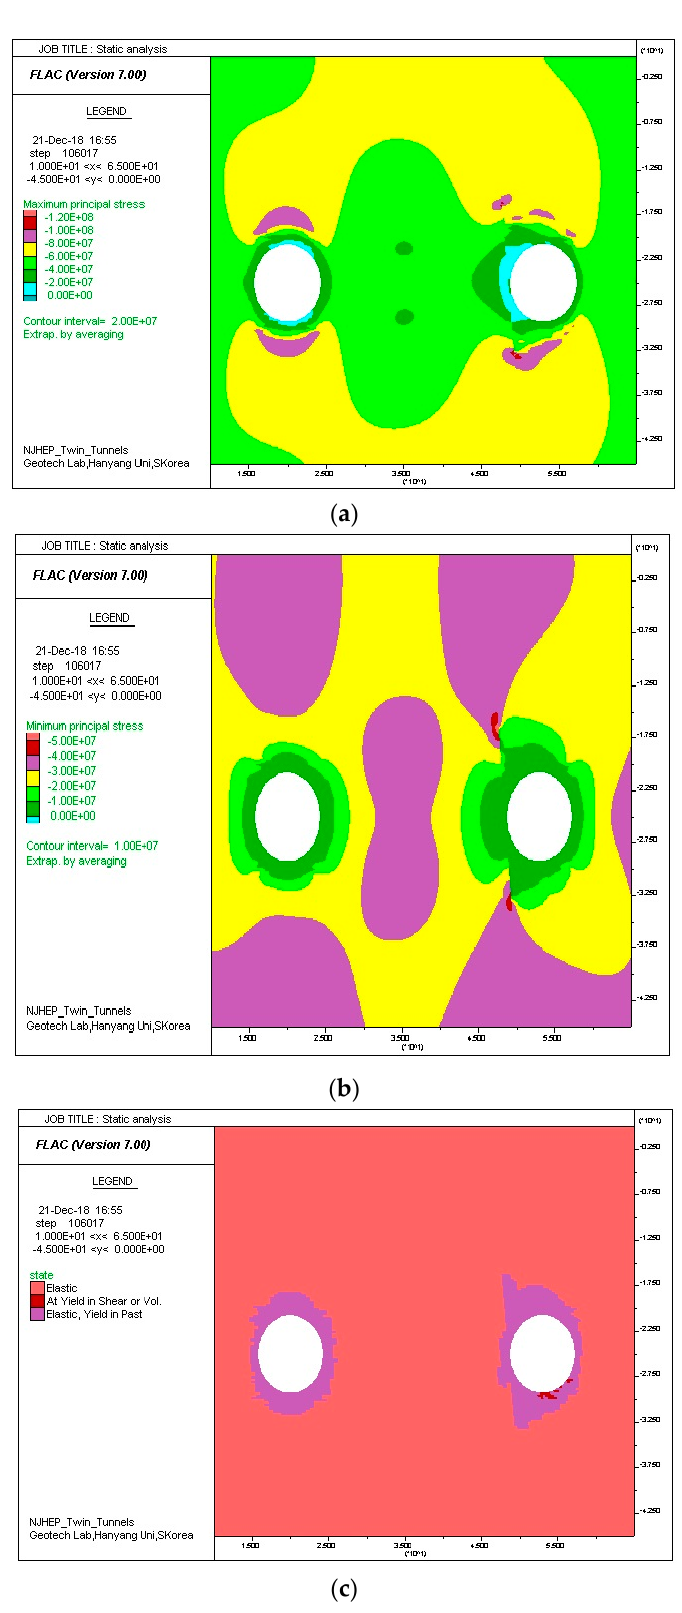
Figure 6. FLAC 2D simulation results for rockburst event in Tunnel 696 (right side of images). ( a ) maximum principal stress; ( b ) minimum principal stress; ( c ) yielded areas.